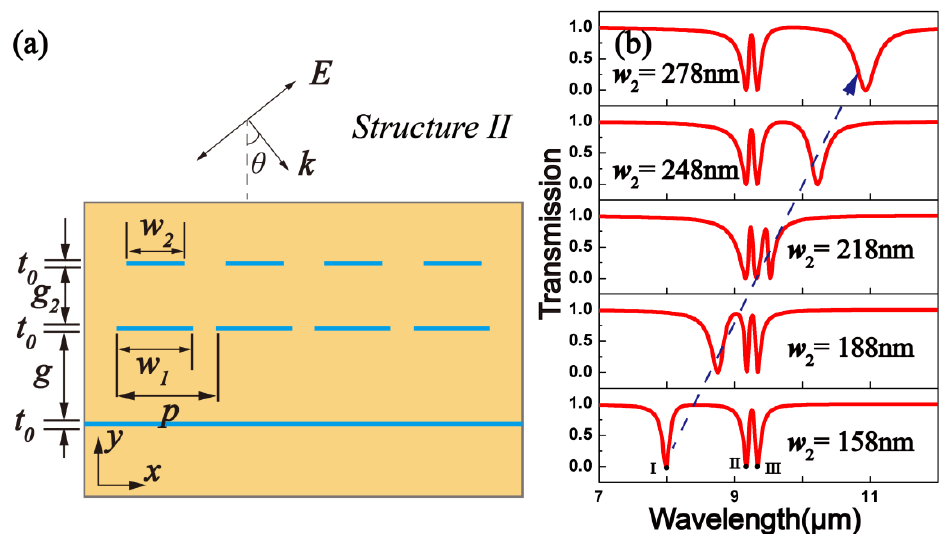
Figure 5. ( a ) Cross-sectional diagram of the second structure proposed; ( b ) Computerized ionospheric tomography transmission spectra at different widths w 2 . Here, p = 600 nm, w 1 = 208 nm, g = 350 nm, and E F = 0.6 eV.